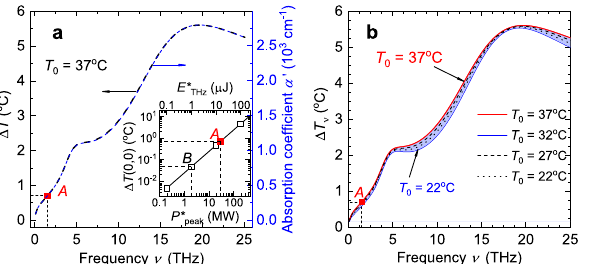
Figure 4. Extending the limits of the FE-model application. ( a ) Temperature increase � T ( 0, 0 ) in the beam’s center and absorption coefficient α ′ as a function of radiation frequency ν ; � T ( 0, 0 ) as a function of pulse energy and peak power (inset). ( b ) Temperature increase � T ν in the beam’s center as a function of frequency for various initial temperatures T 0 . See Data File 32 for underlying